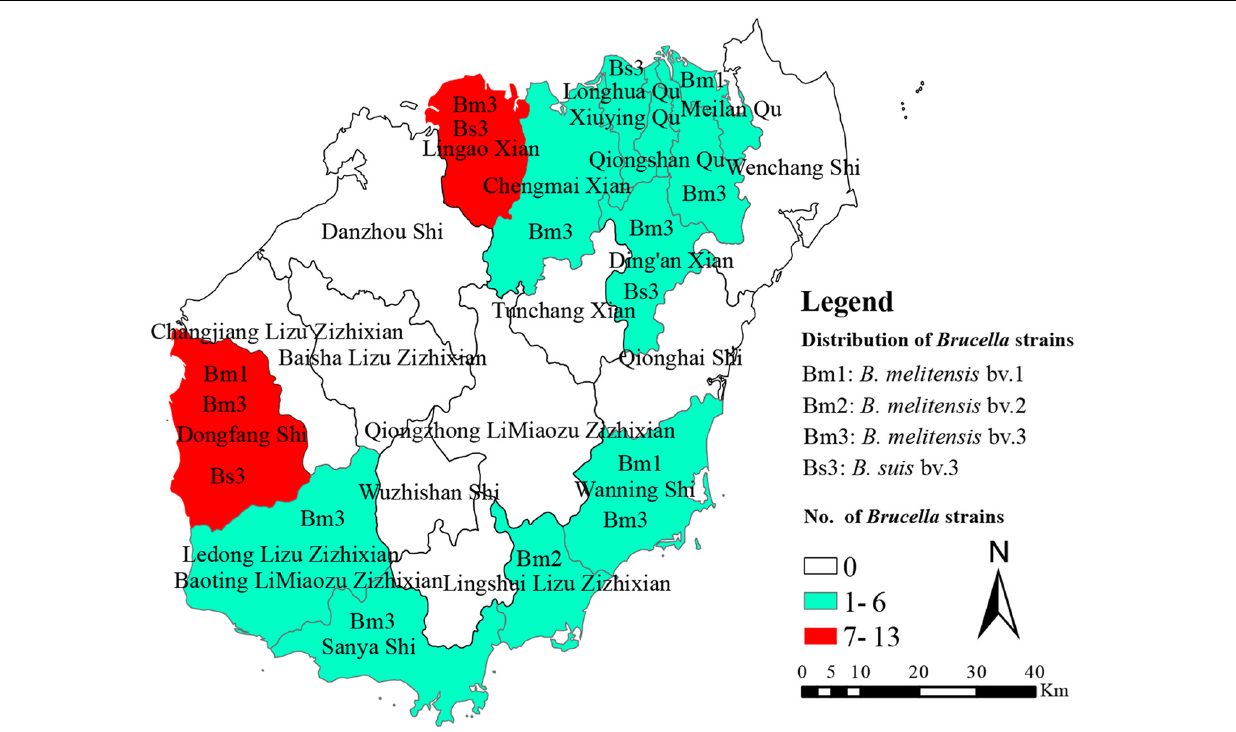
Frontiers in Microbiology |